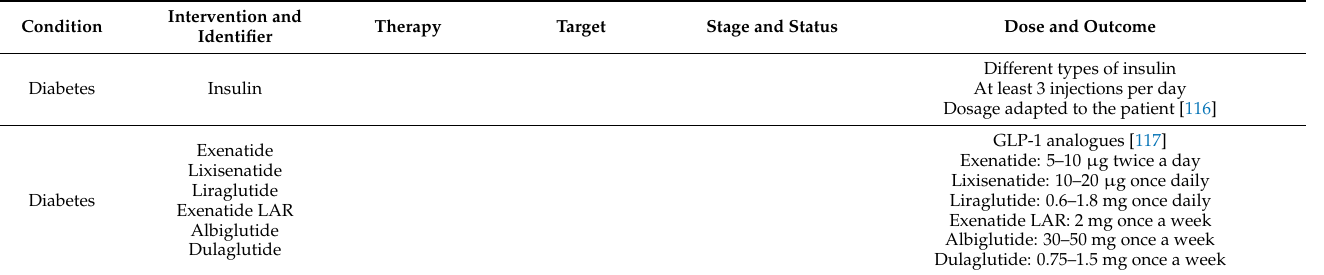
Table 2. Therapies targeting CVD using subcutaneous